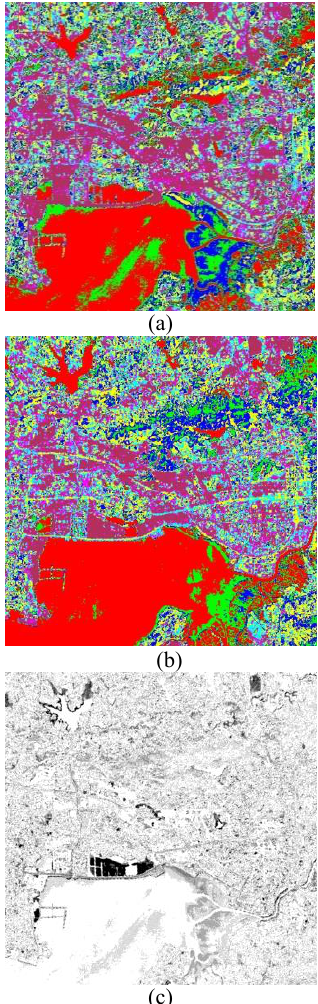
Figure 6 Results of classification and change detection